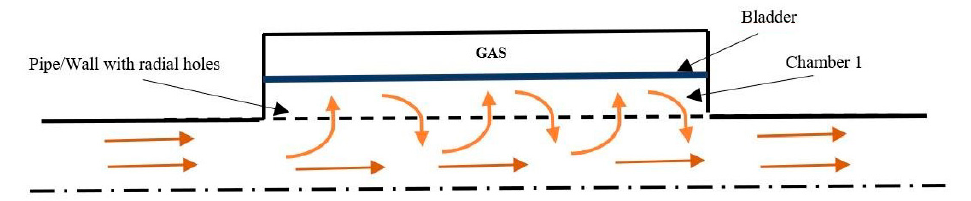
Figure 1. Fluid fl ow inside the damper. Figure 1. Fluid flow inside the